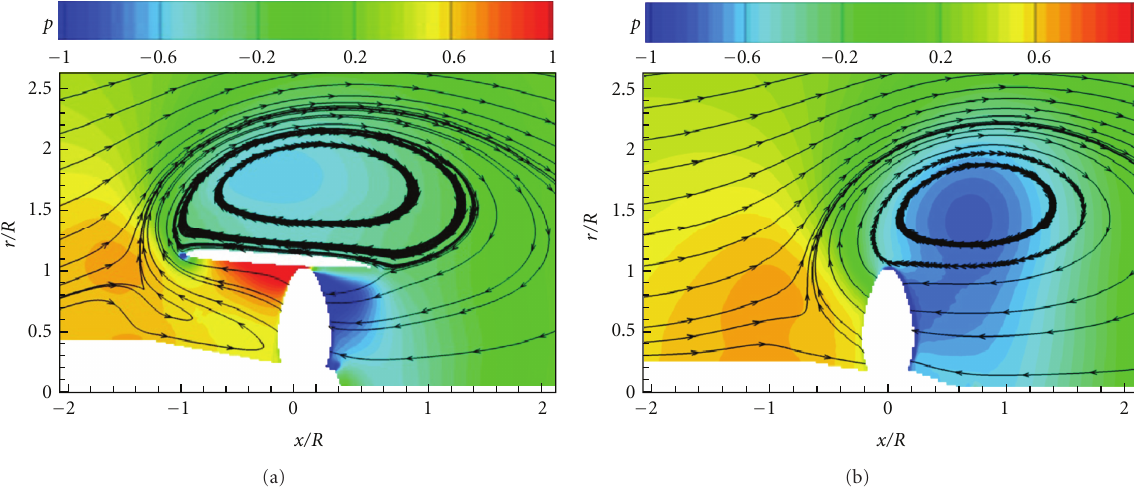
Figure 13: Circumferentially averaged pressure contours with streamlines: (a) ducted propulsor, (b) open propulsor.